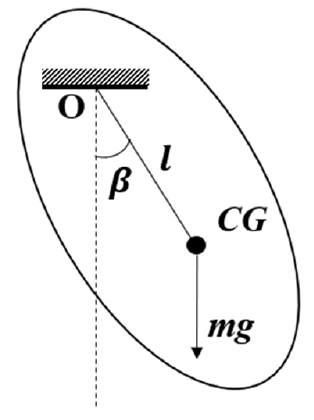
Figure 17. The compound pendulum.